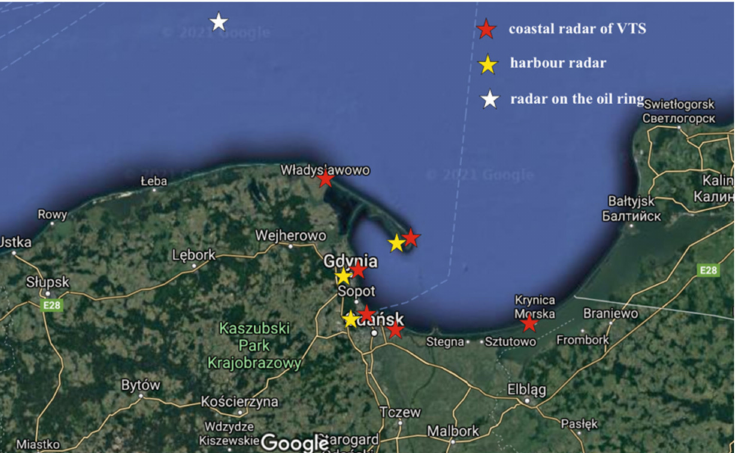
Figure 1. Radar subsystem of the Zatoka Gda´nska VTS System (satellite photo from https://www. google.pl/maps, the accessed date: 14 May